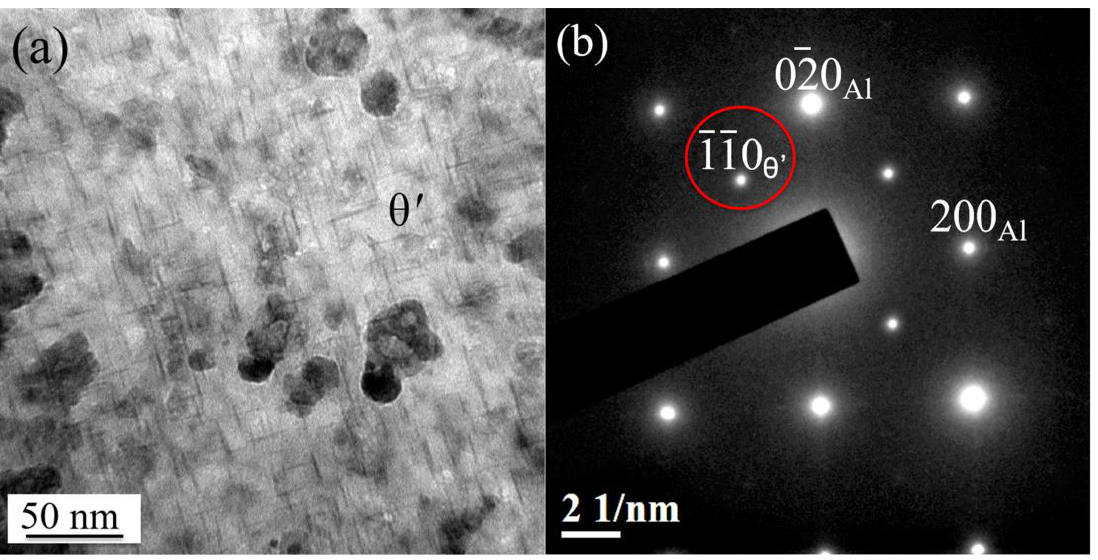
Figure 8. TEM images of T6 heat-treated alloy: ( a ) bright field image and ( b ) selected area electron diffraction pattern. The brighter diffraction spot at the center of the red circle corresponded to the (−1 −1 0) plane of the θ’ phase.